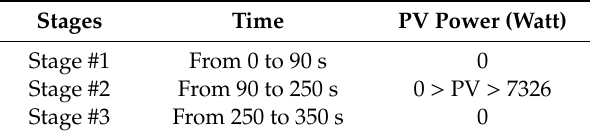
Figure 16. ( a ) Load profile, ( b ) irradiance, ( c ) PV power, ( d ) PV current.